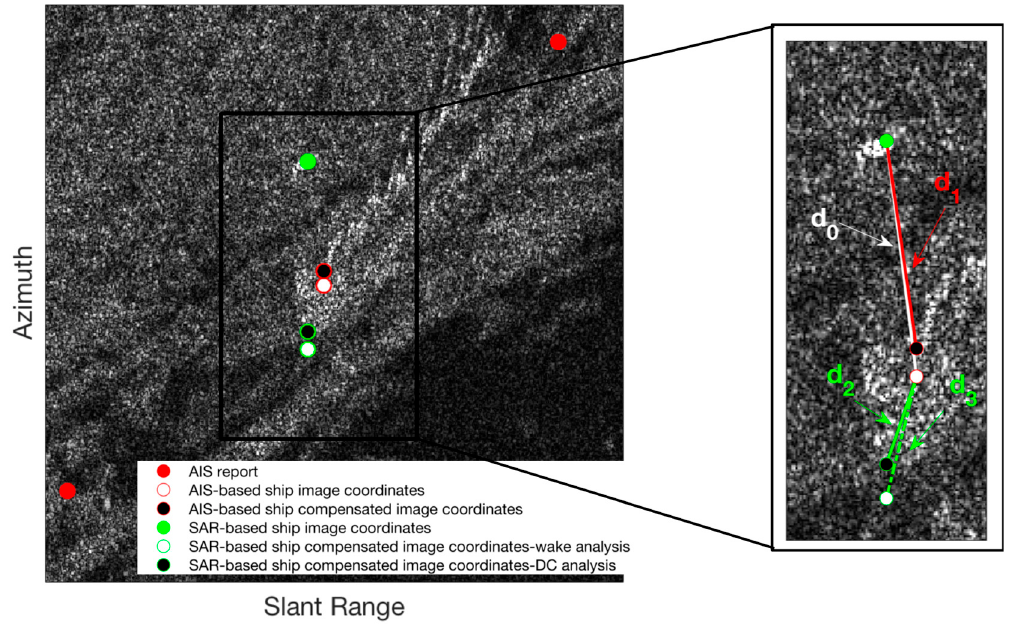
Figure 6. SAR-based and AIS-based ship positions in SAR image domain. Pictorial view of positions and distances ( top ), application example on ship of Figure 1 ( bottom ).